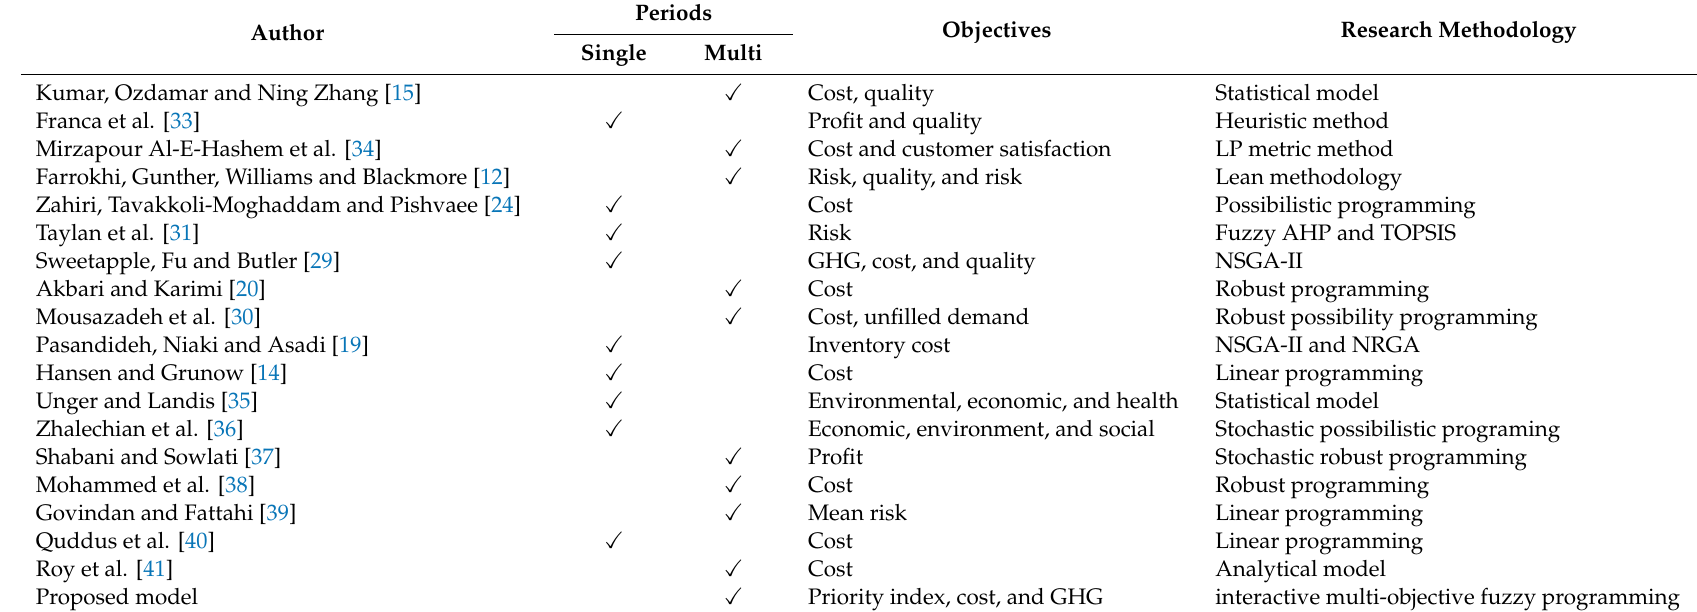
Table 1. Comparison of proposed research with existing